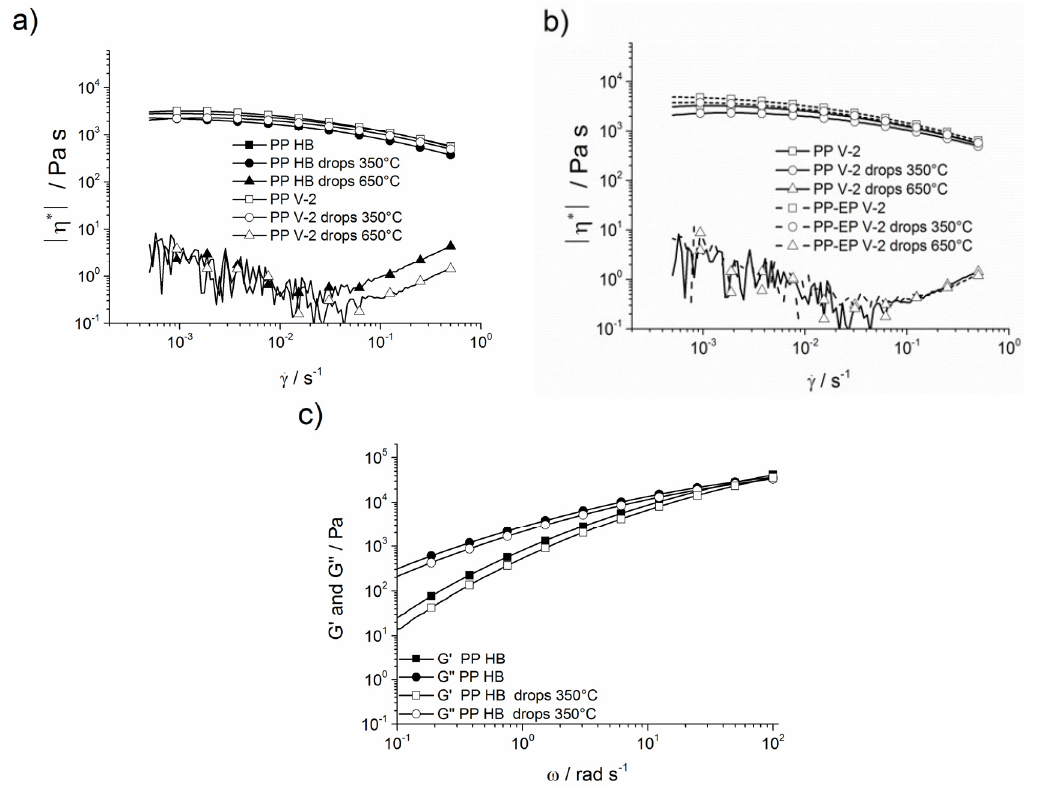
Figure 11. ( a ) Complex viscosity of PP HB, PP V-2 and their molten drops as a function of shear rate; ( b ) complex viscosity of PP V-2, PP-EP V-2 and their molten drops as a function of shear rate; and ( c ) storage modulus and loss modulus of PP HB and its molten drops at 350 °C.